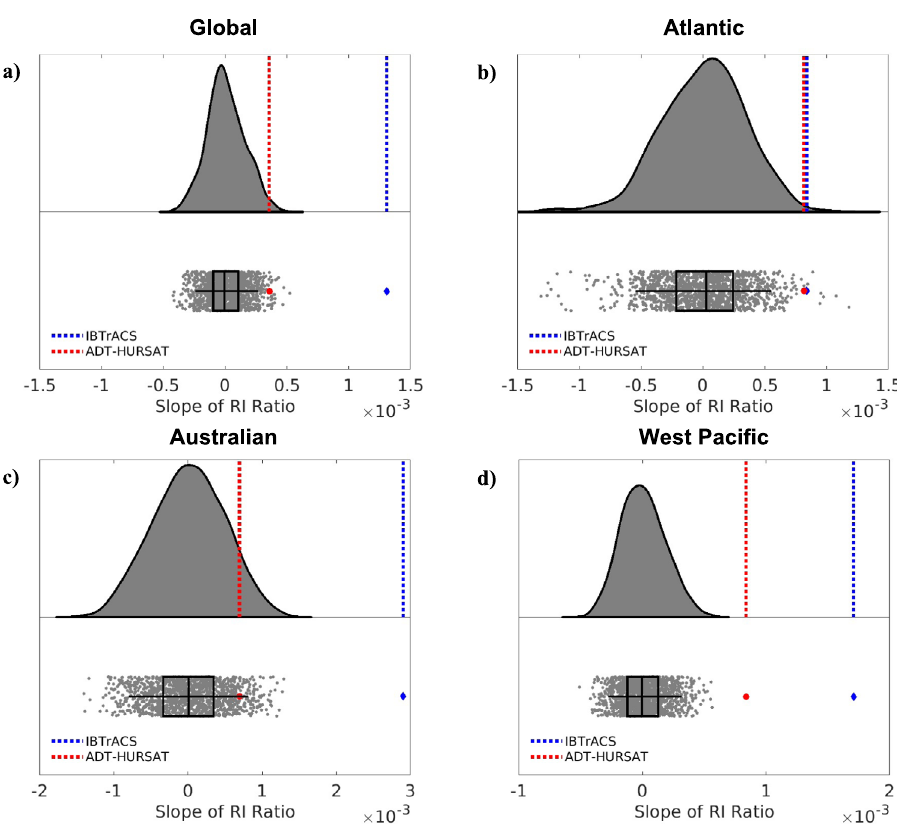
Fig. 2 | Observed trends in rapid intensi fi cation ratio vs. HiFLOR natural variability. Raincloud plots represent the distribution of rapid intensi fi cation (RI) ratio slopes in the Quantile Delta Mapping-corrected 1860 HiFLOR control simu- lation using a half-violin plot (top)and raw jittered data and box-and-whisker plots (bottom) for four basins ( a ) Global ( b ) Atlantic ( c ) Australian( d ) West Paci fi c. Each of the HiFLOR slopes is calculated by applying least squares regression analysis to